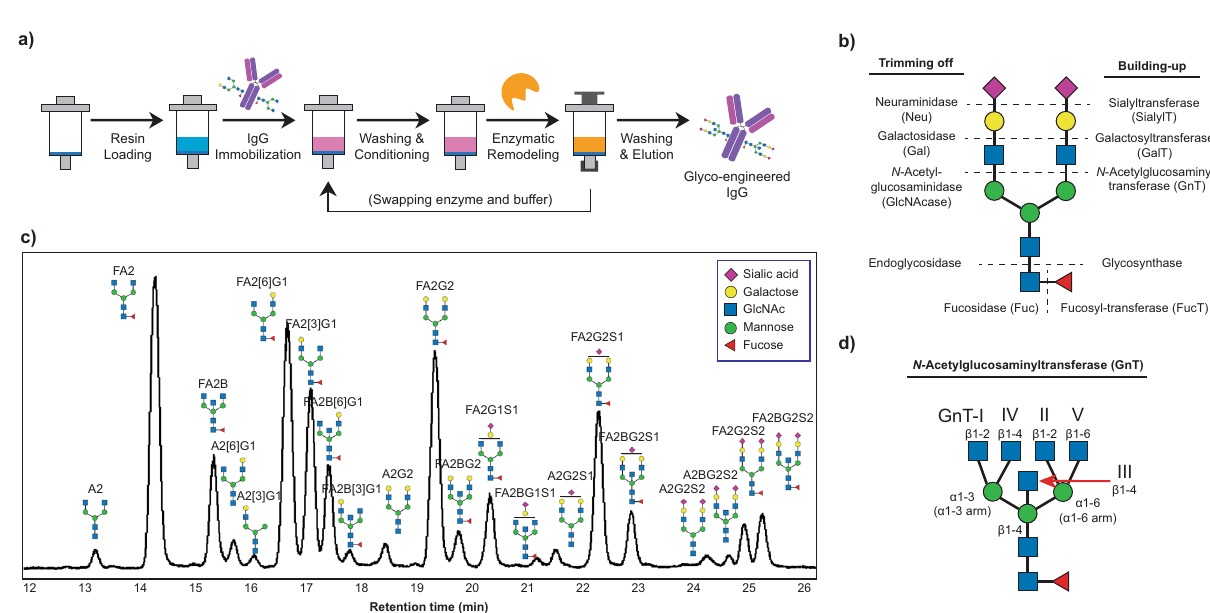
Fig. 1 Enabling enzymatic glycoengineering using a solid-phase platform. a Scheme of solid-phase glycan remodeling (SPGR) protocols. b Enzyme map for bi-antennary N-glycan glycoengineering. c Chromatogram of glycans collected from human serum IgG. The Oxford notation is used for glycan nomenclature. d The functions of N -acetylglucosaminyltransferases (GnTs).